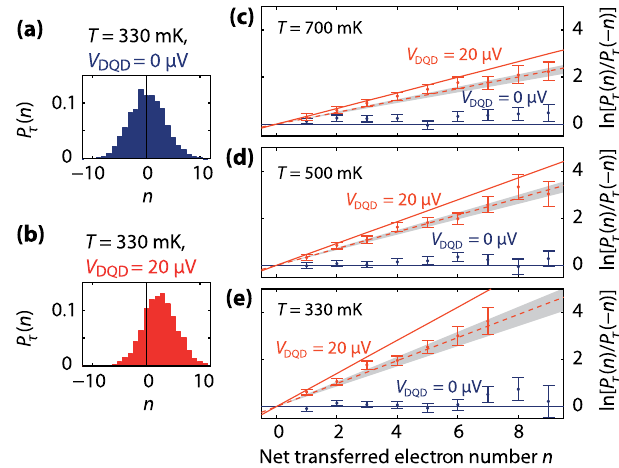
FIG. 2. (a), (b): Experimental probability distributions for the net electron number n transferred through the DQD during time (cid:1) ¼ 2 s for two different DQD source-drain voltages V DQD . (c), (d), and (e): Comparison of experimental data with theory for three different bath temperatures. The data points correspond to the left-hand side of Eq. (2) and describe the probability ratio of forward ( þ n , entropy-producing) and backward ( (cid:1) n , entropy- consuming) processes for a given n . The solid lines mark the expected exponential behavior exp ð neV DQD =k B T Þ for the two source-drain voltages 0 (cid:2) V (dark blue, horizontal) and 20 (cid:2) V (red, inclined). If the finite bandwidth of the detector is taken into account [25,30] (dashed lines), experiment and theory agree within the statistical uncertainty of the data. (Error bars indicate the estimated standard deviation. The gray bands around the dashed lines indicate the uncertainty in the finite-bandwidth